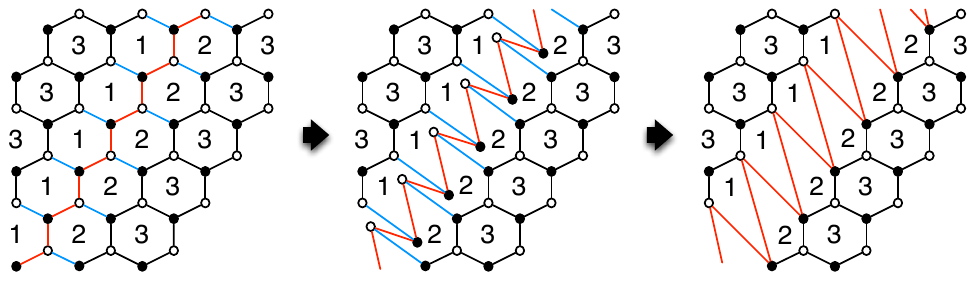
Figure 6. The mass deformation of C 2 = Z 3 (cid:2) C on the dimer. Image from